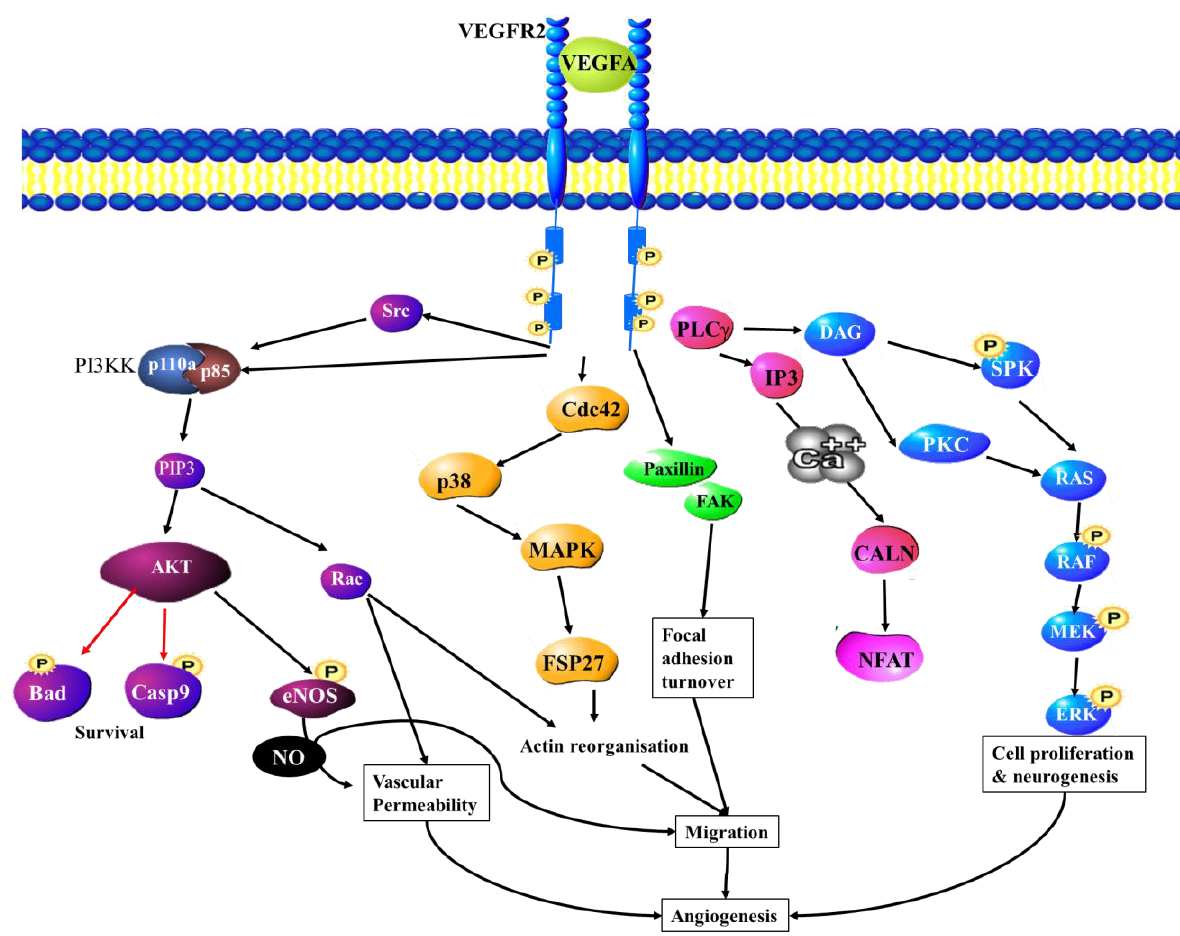
Figure 4. VEGF signaling: VEGFR-2 activation stimulates migration and extracellular matrix (ECM) invasion. The BEGF pathway results in neurogenesis, which leads, in combination with increased vascular permeability, to increased angiogenesis. CASP9 — Caspase9, eNOS — Endothelial NOS, ERK- extracellular signal-regulated kinase, FAK — Protein-tyrosine kinase, FRS2 β— fibroblast growth factor (FGF) receptor substrate 2, FOXO 1/3a — Forkhead family of transcription factors, FSP-27 — Fat specific protein 27, IRS1/2 — Insulin receptor substrate 1/2, MEK-Mitogen activated kinase, NFAT — Nuclear factor of activated T-cells, PIP-2/3-phospholipase, PI3K — Phosphoinositide 3-kinase, PKC — Protein kinase C, PLC γ— Phosphoinositide phospholipase C, Shp2 — Src homology region 2, SPK-SR protein kinase.